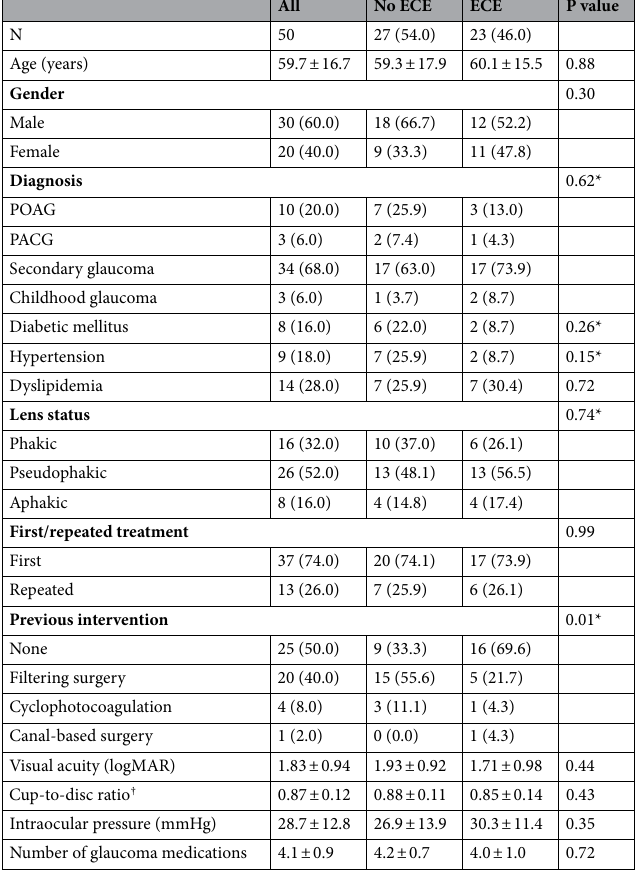
Table 2. Demographic data and baseline characteristics. Data present in N (%) and mean ± standard deviation. Significant p value after Bonferroni correction = 0.004. ECE early ciliochoroidal effusion,